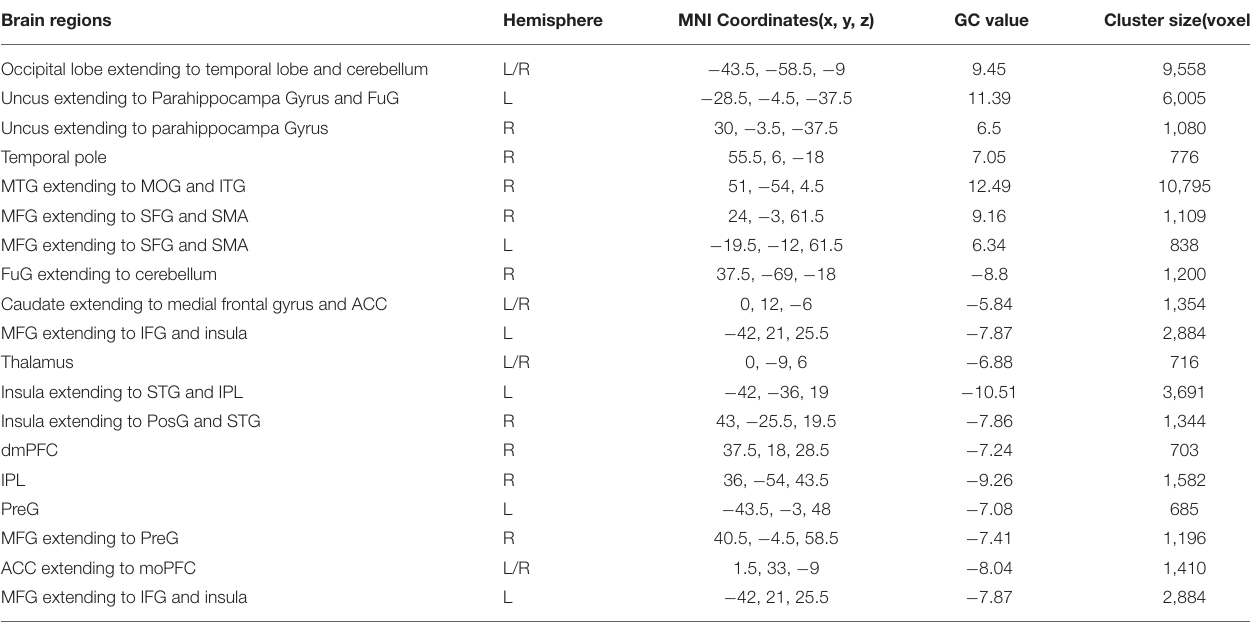
TABLE 3 | The right temporal pole-based CaSCN analysis